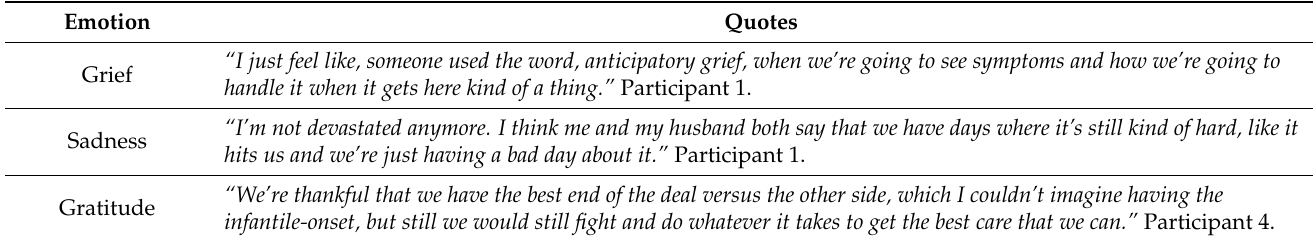
Table 6. Emotions related to participants having a child living with an LOPD